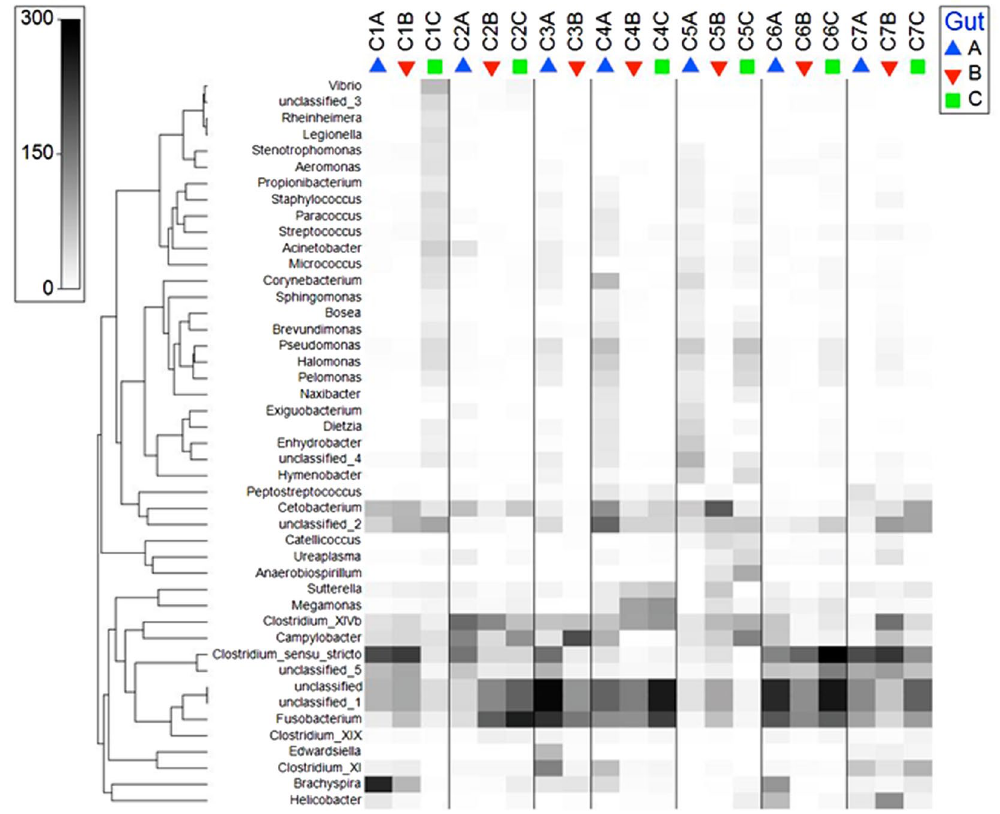
Figure 1. A shade plot presentation of data matrix of all samples showing the dominant OTUs (with minimum of 500 sequences per each OTU in all the samples together) and their taxonomic classification. The different samples are presented in columns. The numbers in the sample name indicate the cormorant individuals; the letters (at the end of the name) A, B, C indicate the three intestine parts: A - esophagus, B - middle, C - cloaca. The grey scale squares are in linear proportion to a square root transformation of the relative abundance of each presented genus or unclassified OTU in a sample. White squares signify the absence of the genera or OTU in a sample. Clustering of the genera (y-axis) was due to similar distribution across the samples. The figure was drawn with the primer 7 software